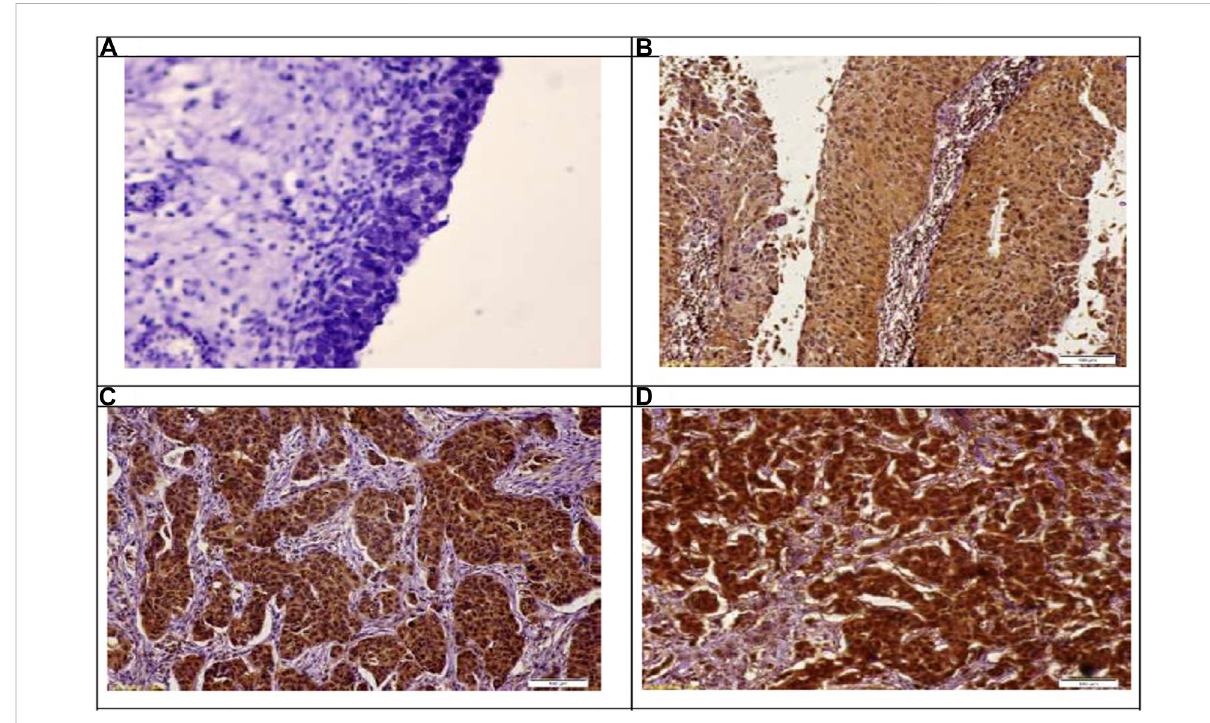
FIGURE 2 Immunohistochemical staining of gasdermin D in the study groups. (A): Showing no expression of gasdermain D at control samples. Immunoperoxidase X 100. (B): Showing weak-mild expression of gasdermain D at stage PTa. Immunoperoxidase X 100. (C): Showing moderate expression of gasdermain D at stage PT2. Immunoperoxidase X 100. (D): Showing marked expression of gasdermain D at stage PT3. Immunoperoxidase X 100.